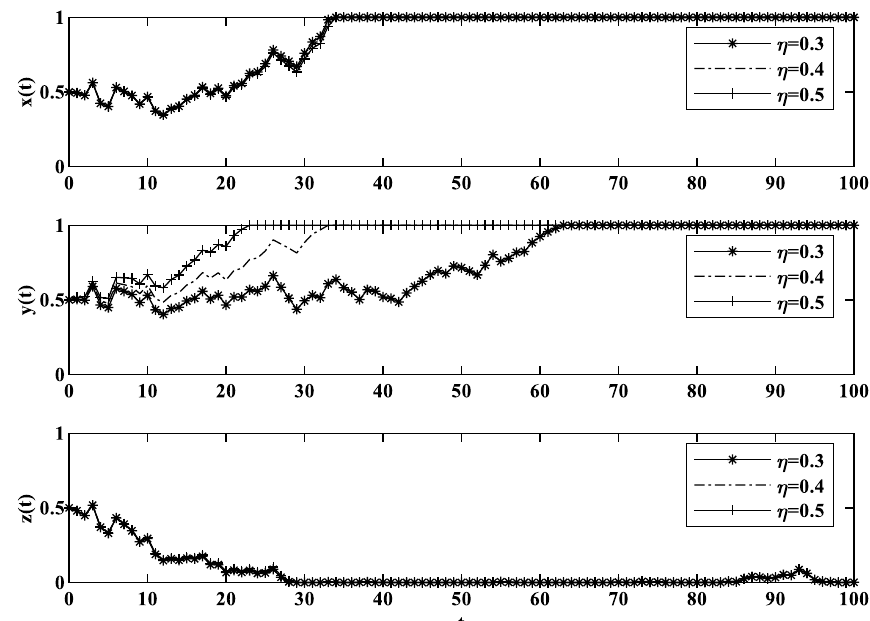
Fig. 15 Impact of ratio of financial budget on evolutionary process under scenario